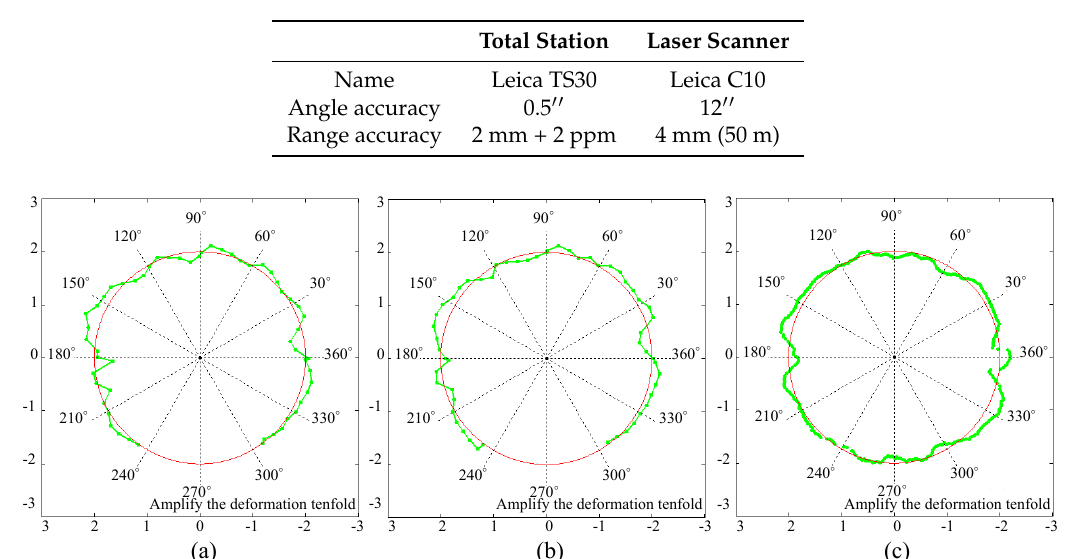
Table 2. The instrument parameters of the laser scanner and the station as a whole used in the two monitoring systems.